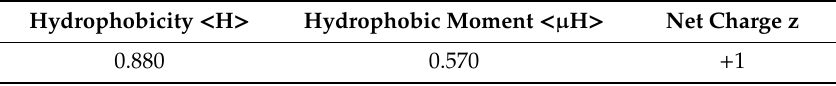
Figure 4. ( a ) Helical wheel diagram and 3D model of kassinatuerin-3 predicted by I-TASSER. ( b ) Circular dichroism (CD) spectra of 50 µM kassinatuerin-3 in aqueous solution (10 mM NH 4 AC) and Table 1. Physiochemical properties of kassinatuerin-3.